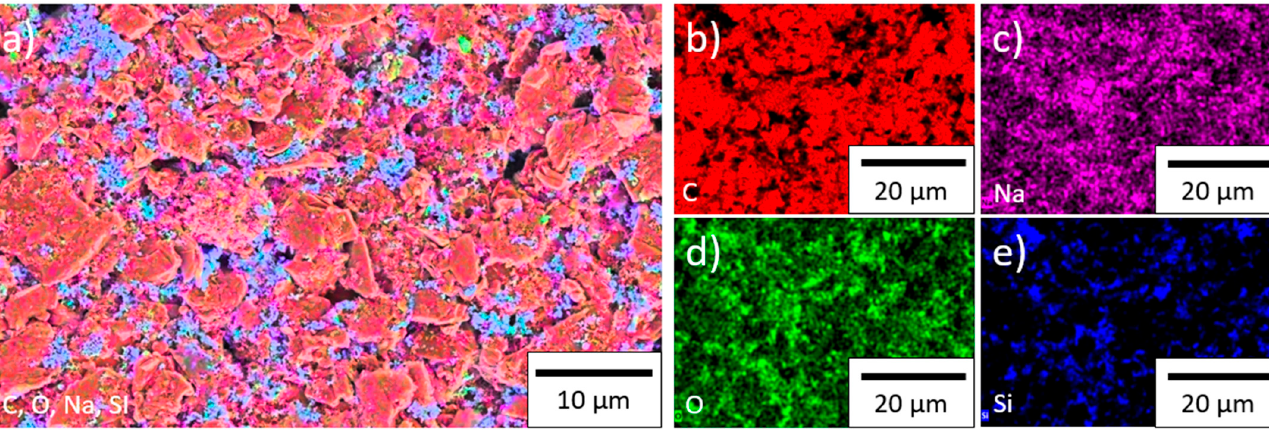
Table A2. Cell balancing factor of each pouch cell. Patterning